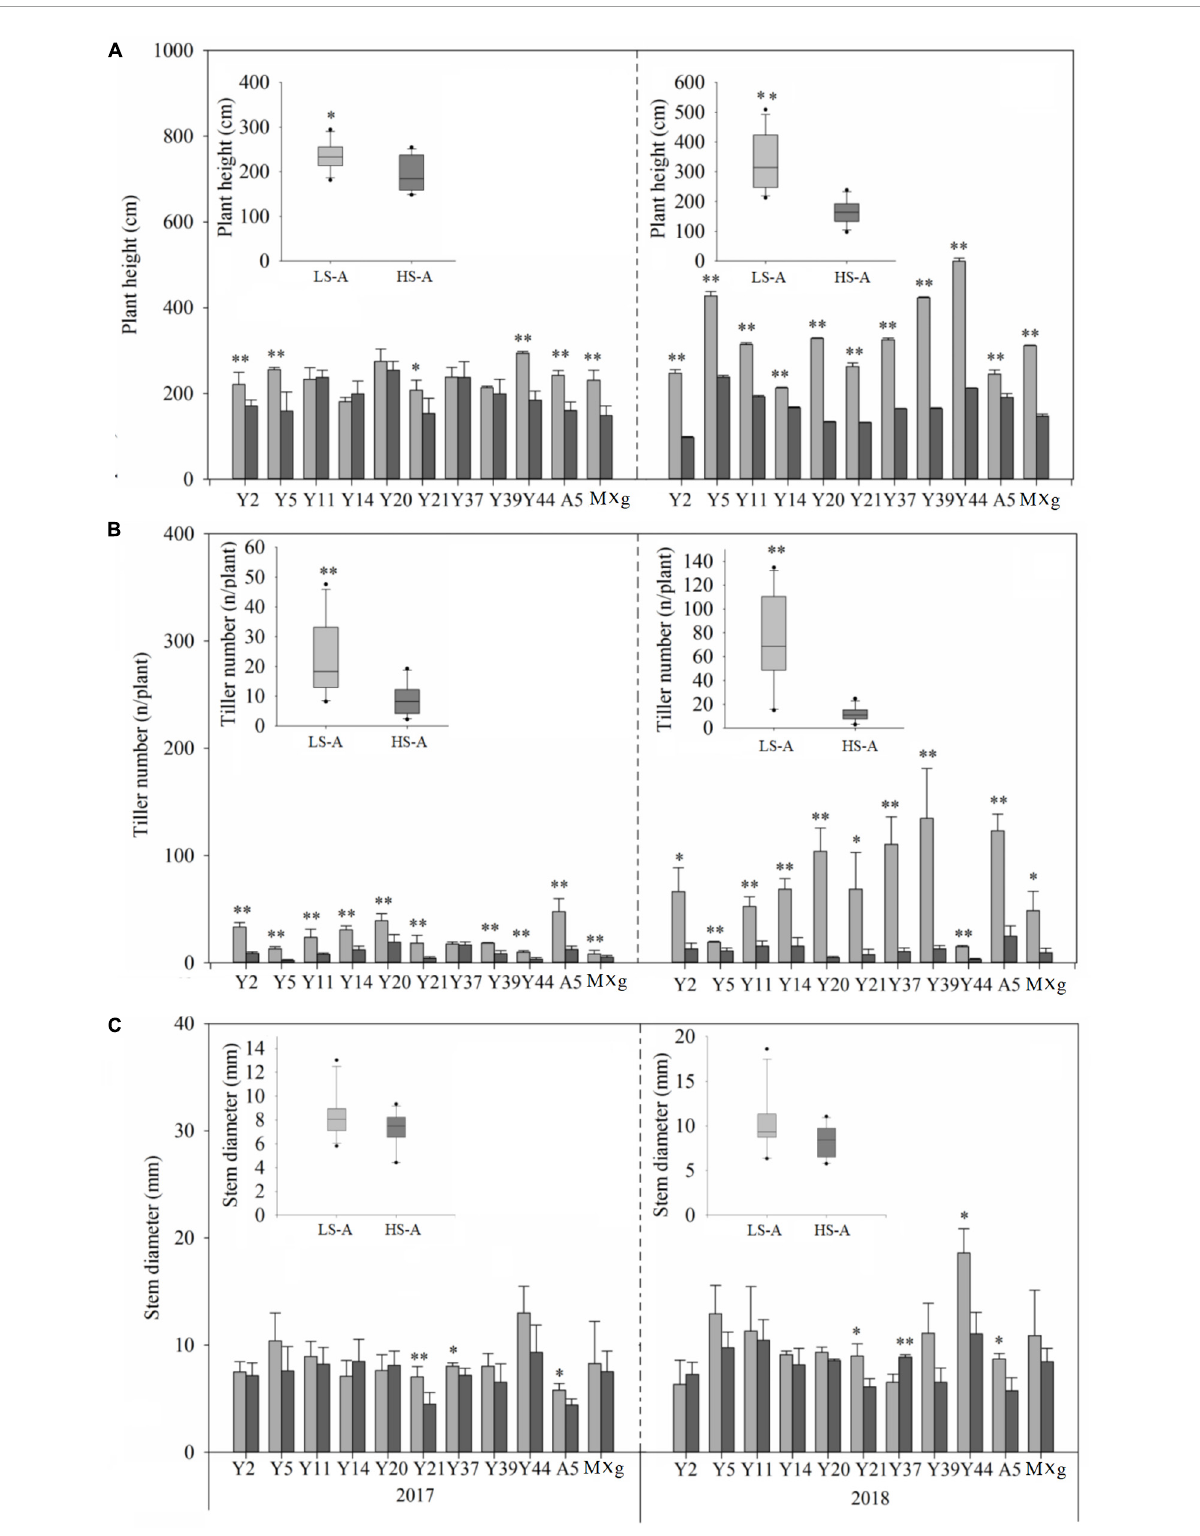
FIGURE3 (A) Plant height, (B) tiller number, and (C) stem diameter of 11 genotypes of Miscanthus grown in low saline–alkaline soil (LS-A) (the light bars) and high saline–alkaline soil (HS-A) (the dark bars). Significance is denoted by ∗ P < 0.05 and ∗∗ P <